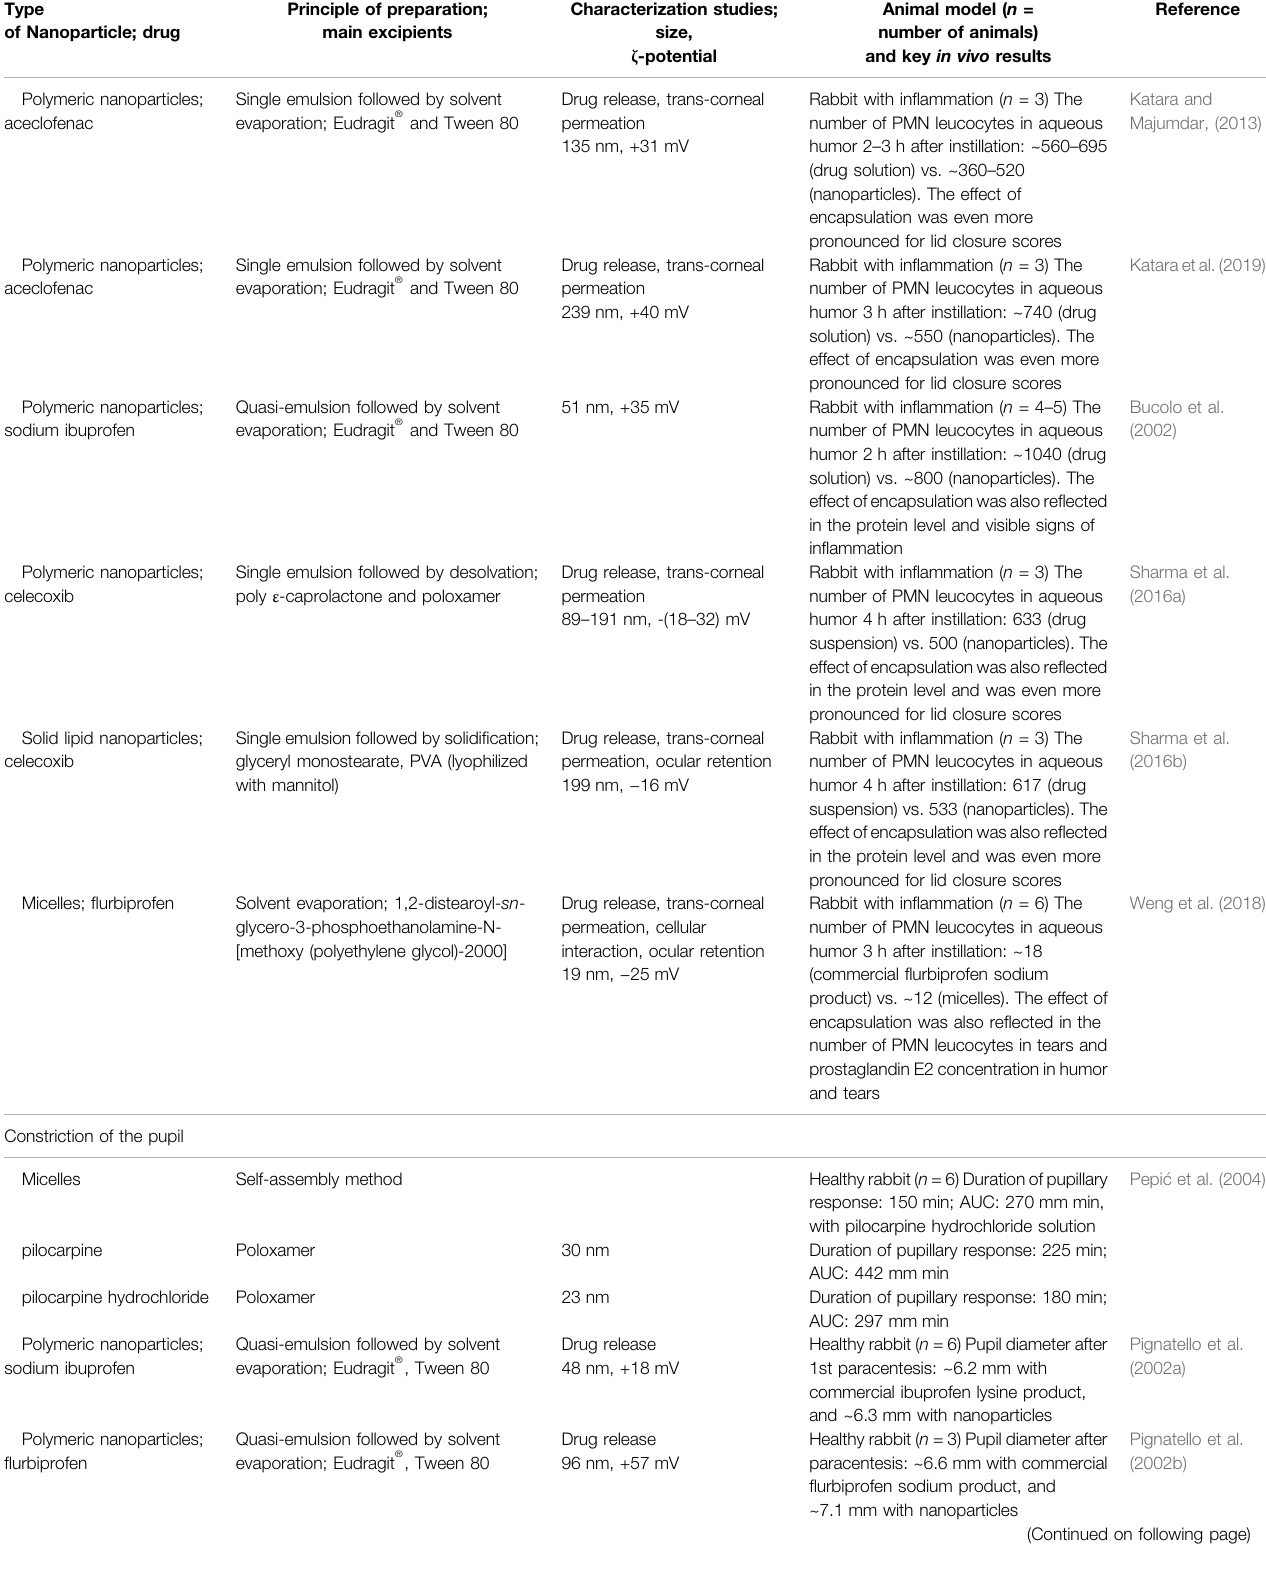
TABLE 4 | ( Continued ) Summary of in vivo studies on nanoparticle-based systems used for drug delivery to anterior segment of the